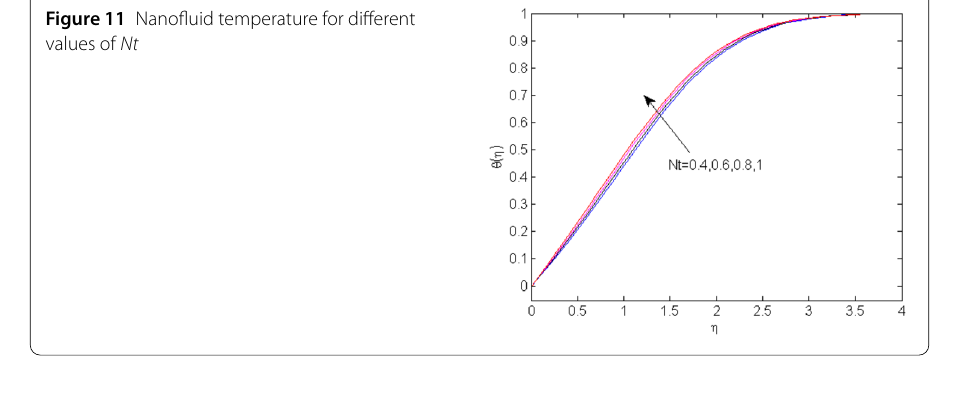
Figure 11 Nanofluid temperature for different values of Nt